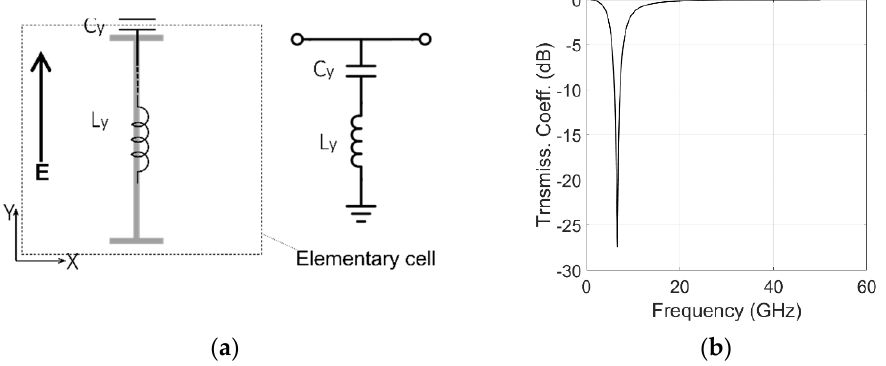
Figure 4. Equivalent circuit model of the ‘I’-type strip for a y- polarized impinging wave. ( a ) Equivalent circuit; ( b ) transmission coefficient with Cy = 72 fF, Ly = 6.3 nH.